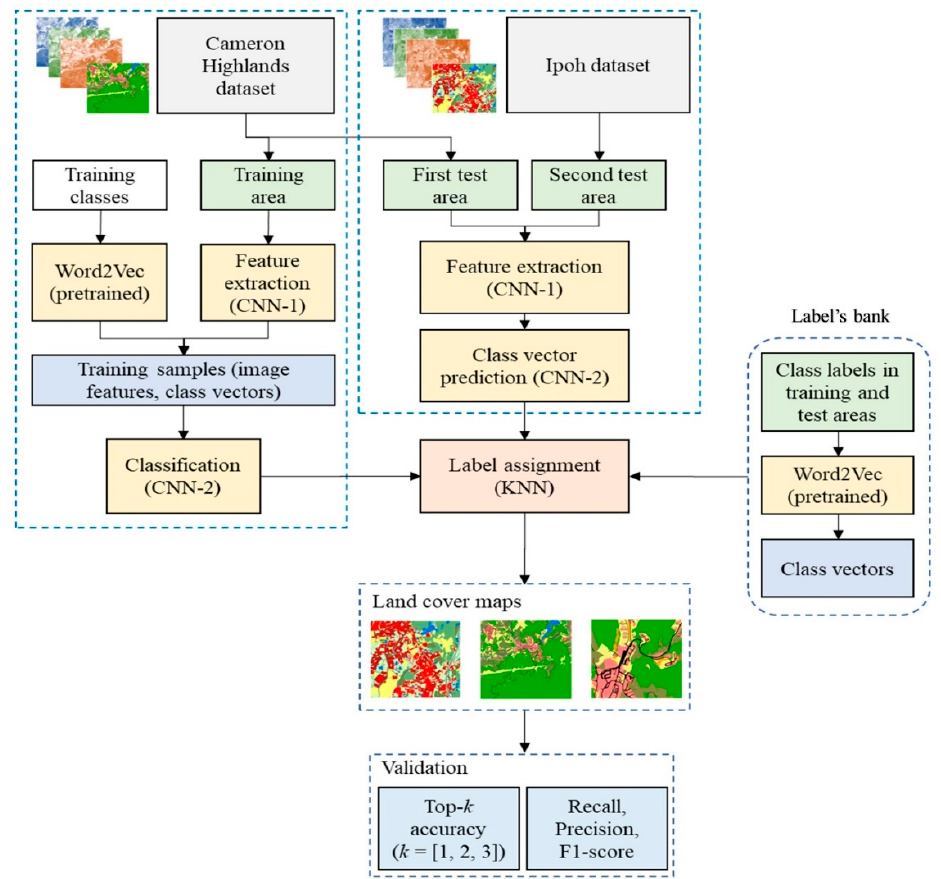
Figure 1. The overall workflow of the proposed ZSL framework.